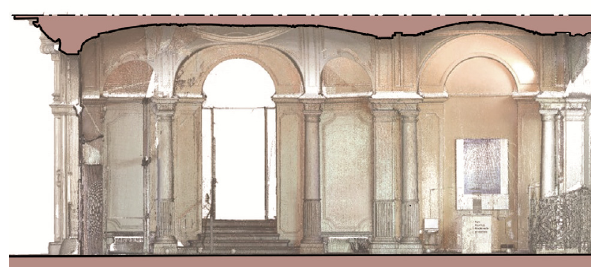
Figure 6 . Longitudinal section at 1:50 scale of Palazzo Mazzonis atrium. Drawing: M. Vitali.